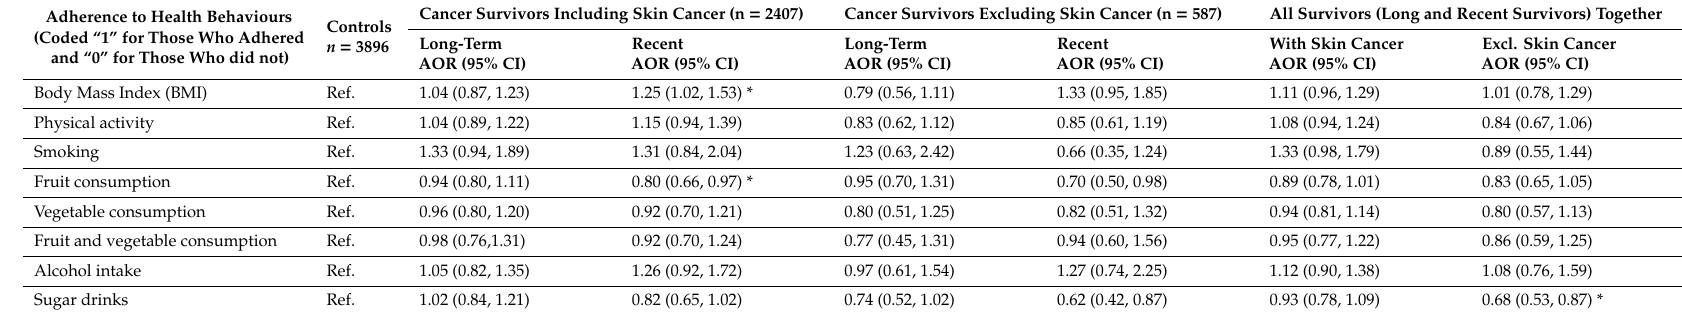
Table 4. Adherence to individual health behaviours between recent, long-term, and all cancer survivors (with and without skin cancer survivors) compared with